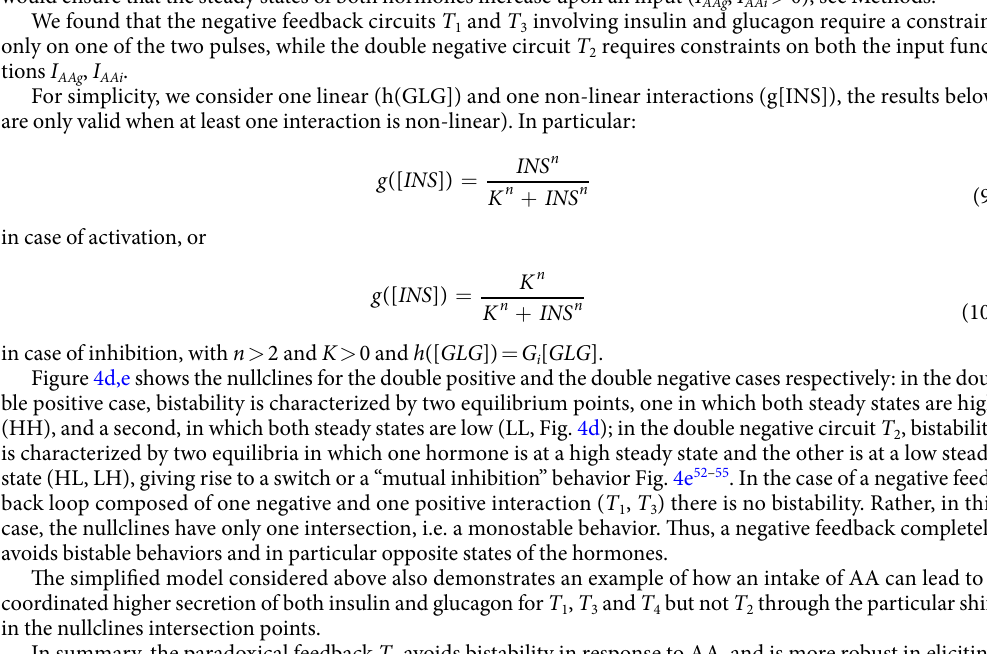
where, [ GLG ] and [ INS ] are the two hormones, α and μ are the basal production rates for the two hormones, g g ([ INS ]) and G i h ([ GLG ]) are two general functions, representing the actions of one hormone on the other: in the double positive case T 4 both g ([ INS ]) and h ([ GLG ]) are increasing, in the double negative case